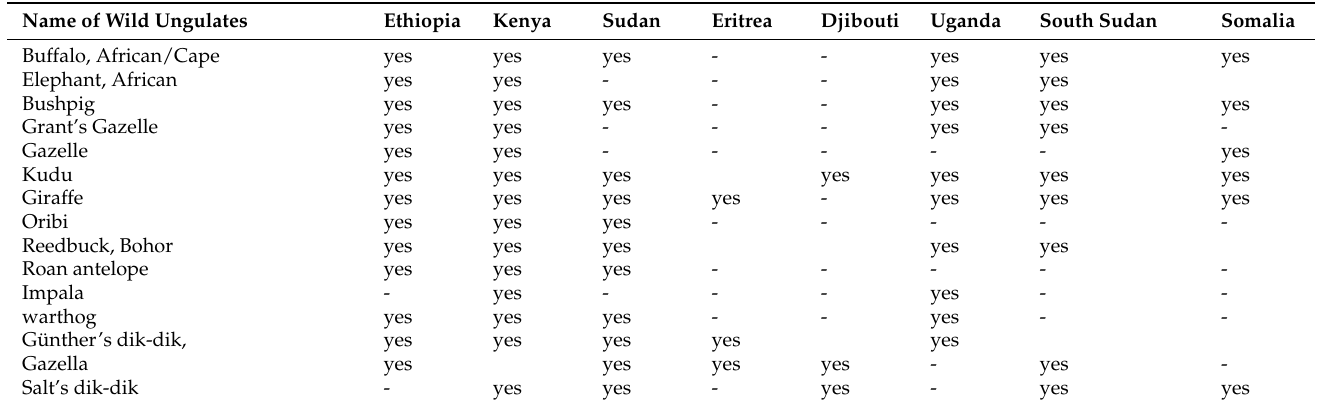
Table 1. List of wild ungulate species present in the Horn of Africa countries that are susceptible to FMDV infection, according to Swanepoel et al.